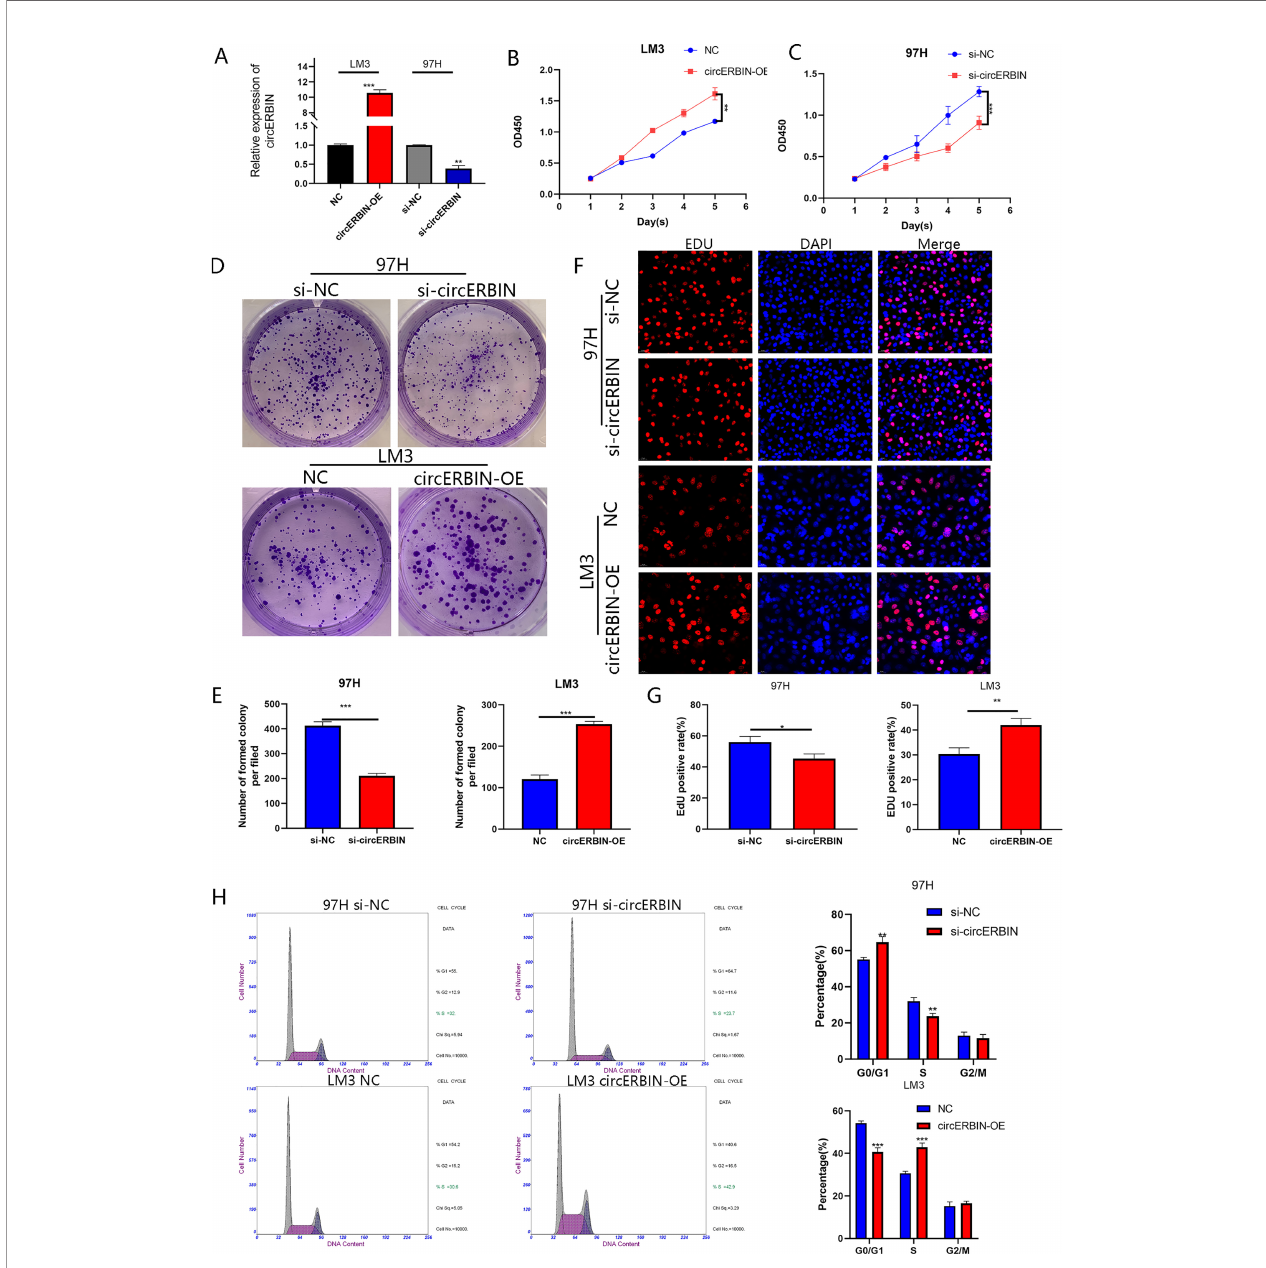
FIGURE 2 | CircERBIN promotes the proliferation and G1/S transition of HCC cells. (A) Expression of circERBIN was con fi rmed by qRT-PCR in HCC cells transfected with NC, circERBIN, si-NC, or si-circERBIN. (B) CCK-8 assay of 97H cells after circ-ERBIN knockdown. (C) CCK-8 assay of LM3 cells overexpressing circERBIN. (D, E) Effects of si-ERBIN and circERBIN-OE on proliferation of HCC cell lines by a colony formation assay. (F, G) EdU assays of LM3 and 97H cells treated with circERBIN or si-circERBIN. (H) Flow cytometry assays showing that circERBIN can accelerate G1 to S phase transition, while circERBIN knockdown increased the proportion of cells in the G1 phase. (* p < 0.05, ** p < 0.01, *** p <